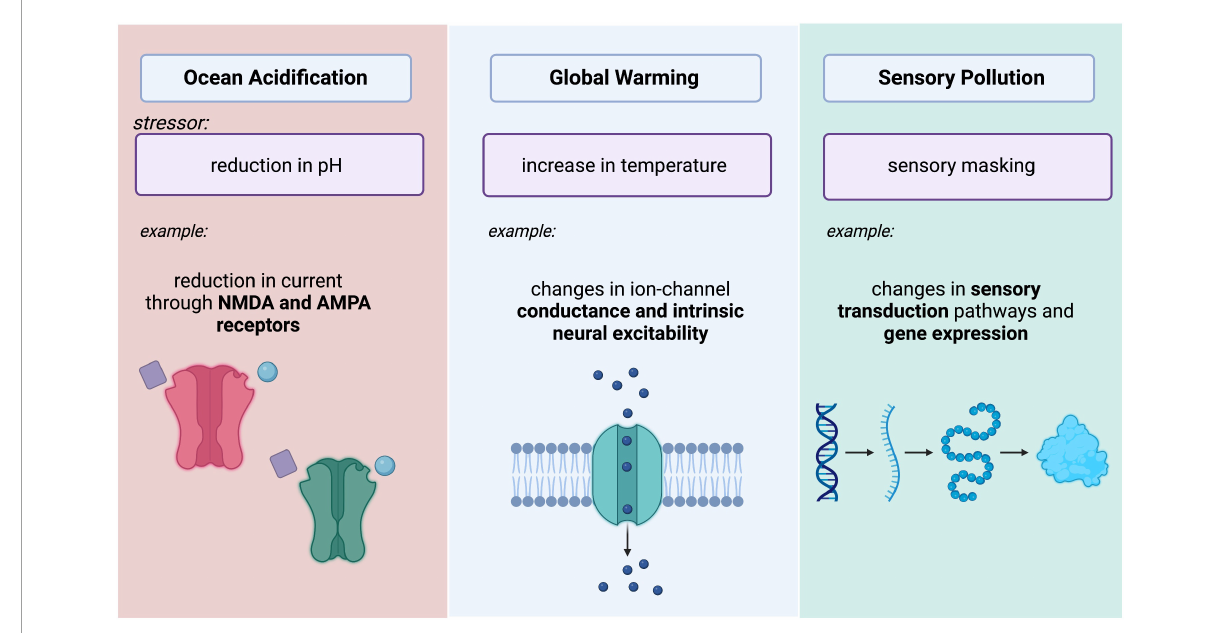
FIGURE1 Summary schematic depicting three major changes in ecosystems that impose stressors on neural systems. Ocean acidification causes decreases in aquatic pH, potentially leading to reductions in current through NMDA and AMPA Receptors. Increasing temperatures impact intrinsic excitability of neurons. Changes in sensory environments due to sensory pollution (light, noise, and chemical pollution) may lead to changes in sensory transduction and gene expression. Image created with